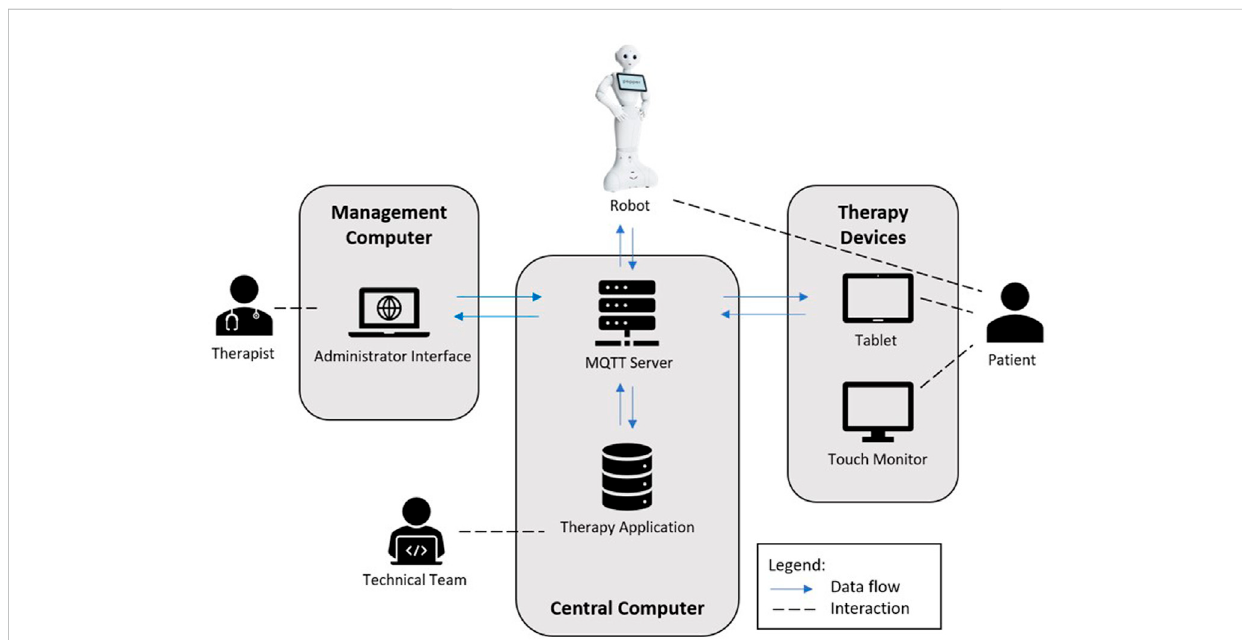
FIGURE 1 In this fi gure, the technical setup and roles of the patients, therapists, and technical team (programmers) are depicted. All devices are connected via Wi-Fi in the same network. The main program fi les of the system are hosted on a central computer running on Cent OS (Linux operating system; https:// www.linux.org). The software of the therapy application consisting of the python dialog scripts, database, therapy management interface, and communication is deployed on this computer. During a therapy session, all device interactions are transmitted via the OASIS standard messaging protocol for the IoT MQTT (https://mqtt.org/) and processed on the computer. The main focus is to offer therapy sessions for the patient. To organize a therapy and its sessions, a therapist creates a patient entry in the system database via the therapy administration interface and con fi gures the therapy sessions. The interface can be accessed on any generic computer inside the system network. The humanoid robot Pepper (https://www.unitedrobotics. group/products-services/hardware/),theAndroidOStablet,andthetouchmonitorarerunningappsdevelopedforthetherapies.Therobotprovidesthe verbal dialog to patients while the other devices are used in parallel to display images, videos and subtitles (e.g., for instruction purposes), diagrams (e.g., for knowledge of result feedback), or plain text (e.g., “ do you need a break? “ ) and to support the robot program with patients ’ entries (e.g., “ ready to continue ” ). A system programmer of the technical team has access to the system to check for errors and possibly fi x errors on the